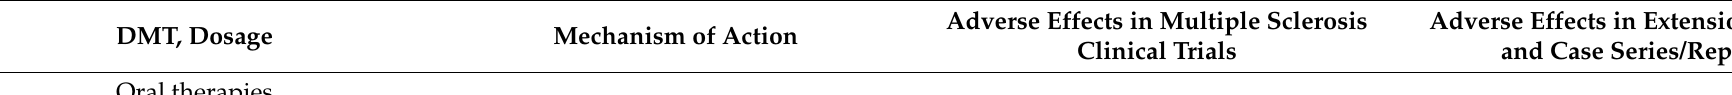
Table 1. Multiple sclerosis disease modifying therapies: adverse events from clinical trials, extension studies, and clinical